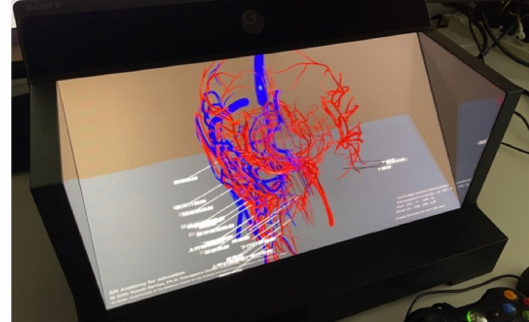
Figure 2. One example of SR Anatomy.